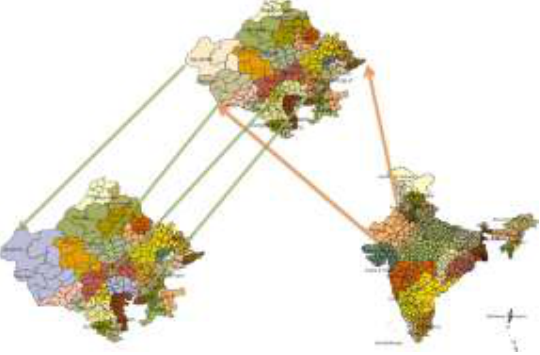
Figure-1-Study Area: Districts of Bhilwara, Barmer and Jaisalmer Rajasthan State, India